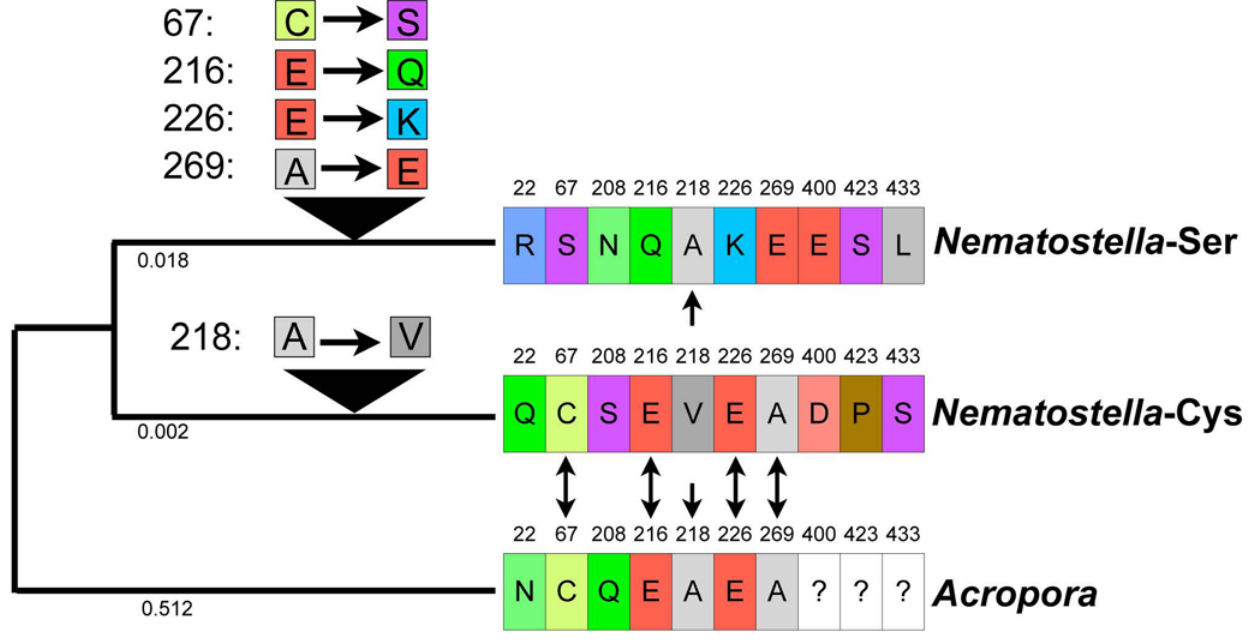
Figure 3. Inferred evolution of polymorphic positions. A partial coding sequence of the coral Acropora millepora was used to root a phylogenetic tree relating the two Nematostella alleles. A neighbor-joining tree was constructed using the computer program Phylip (version 3.6). Distances between sequences were computed using the first 330 amino acids of the alignment (shown in Figure S3) and the JTT distance matrix. Numbers below branches indicate phylogenetic distance (in units of expected number of substitutions per residue). Positions that are polymorphic in Nematostella are shown to the right. The Acropora sequence was identical to one of the two Nematostella variants at five positions (double-headed arrows). For each of these five positions, substitutions were mapped to either the branch leading to the Ser allele or the branch leading to the Cys allele, assuming that the condition found in Acropora is the ancestral state.